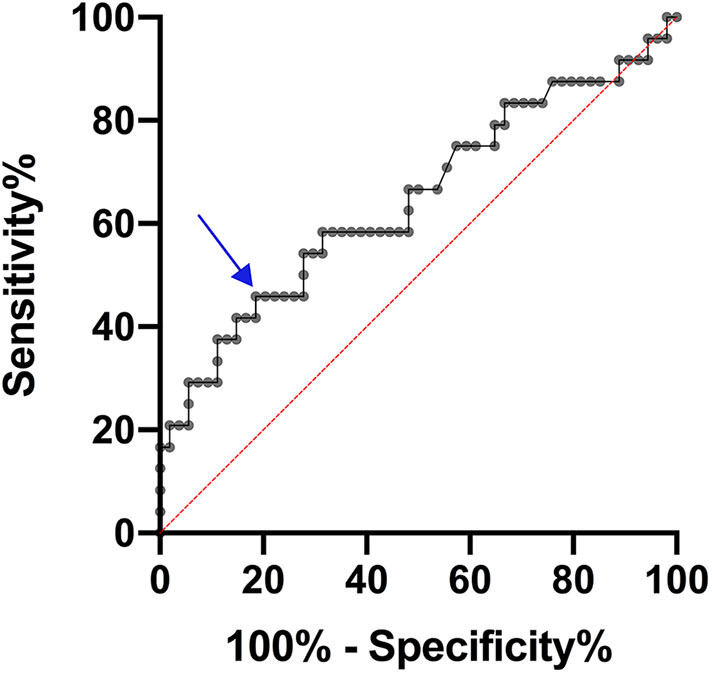
ROC curve for predicting further cerebrovascular events through measure of plasma hs-CRP levels. The arrow shows the cut-off point of hs-CRP = 3.25 μg/ml corresponding to 46% sensitivity and 81% specificity.